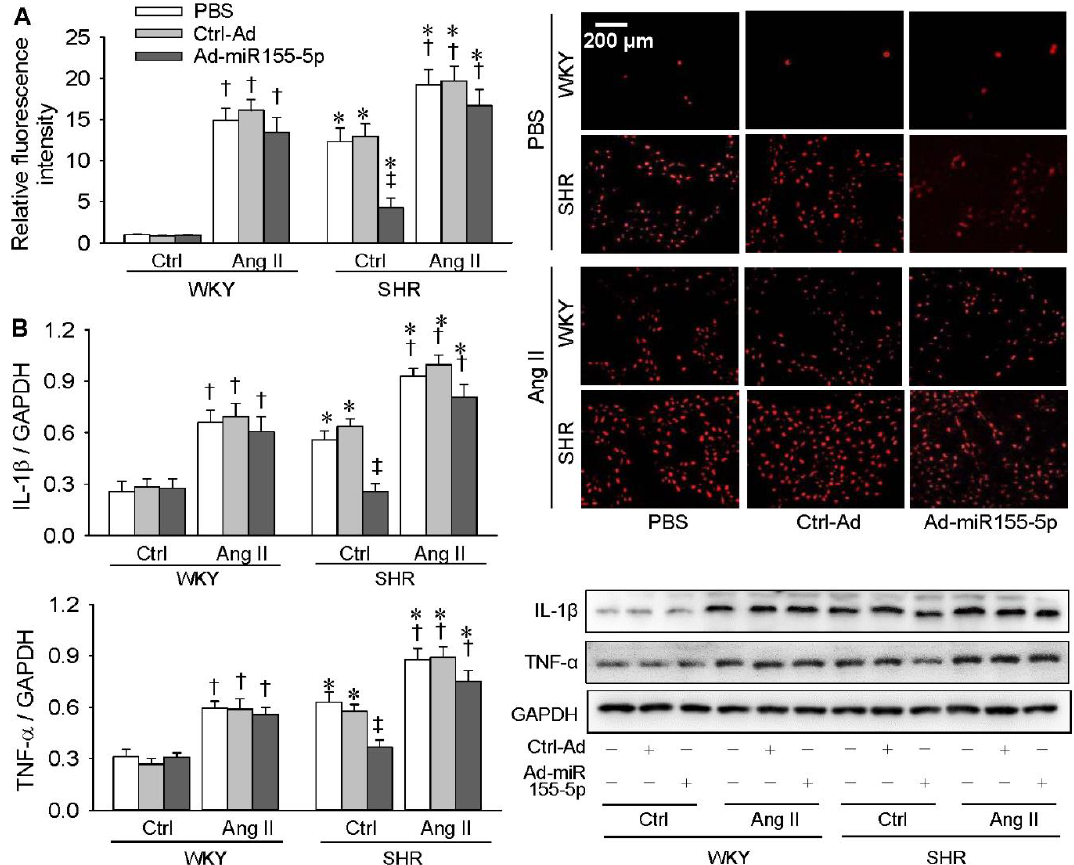
Figure 7. Effects of miR155-5p overexpression on Ang II-induced oxidative stress and inflammation in VSMCs. VSMCs of WKY rats and SHR were treated with PBS, control adenovirus (Ctrl-Ad), or miR155-5p adenovirus (Ad-miR155-5p, 40 MOI) for 24 h, followed by PBS or Ang II treatment (100 nM) for another 24 h. ( A ) DHE fluorescence staining for detecting ROS in VSMCs. ( B ) Interleukin-1β (IL-1β) and tumor necrosis factor α (TNF-α) protein expression levels in VSMCs. Values are mean ± SE; * p < 0.05 vs. WKY; † p < 0.05 vs. Ctrl; ‡ p < 0.05 vs. PBS or Ctrl-Ad; n = 6 per group in A; n = 4 per group in B.